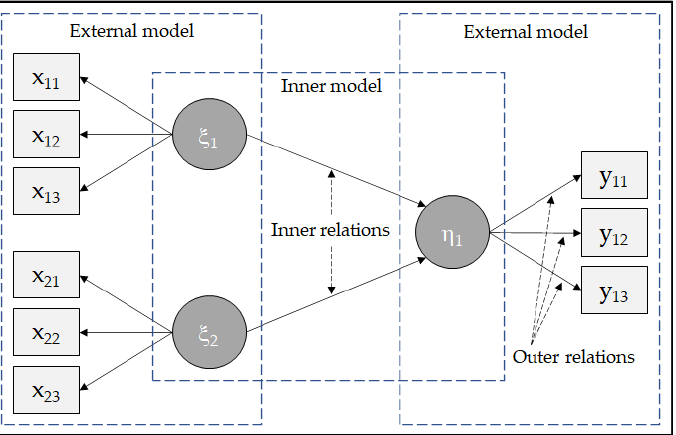
Figure 2. Conceptual PLS model (adapted with permission from [58]. Copyright 2022, Zoran Ka- linic).